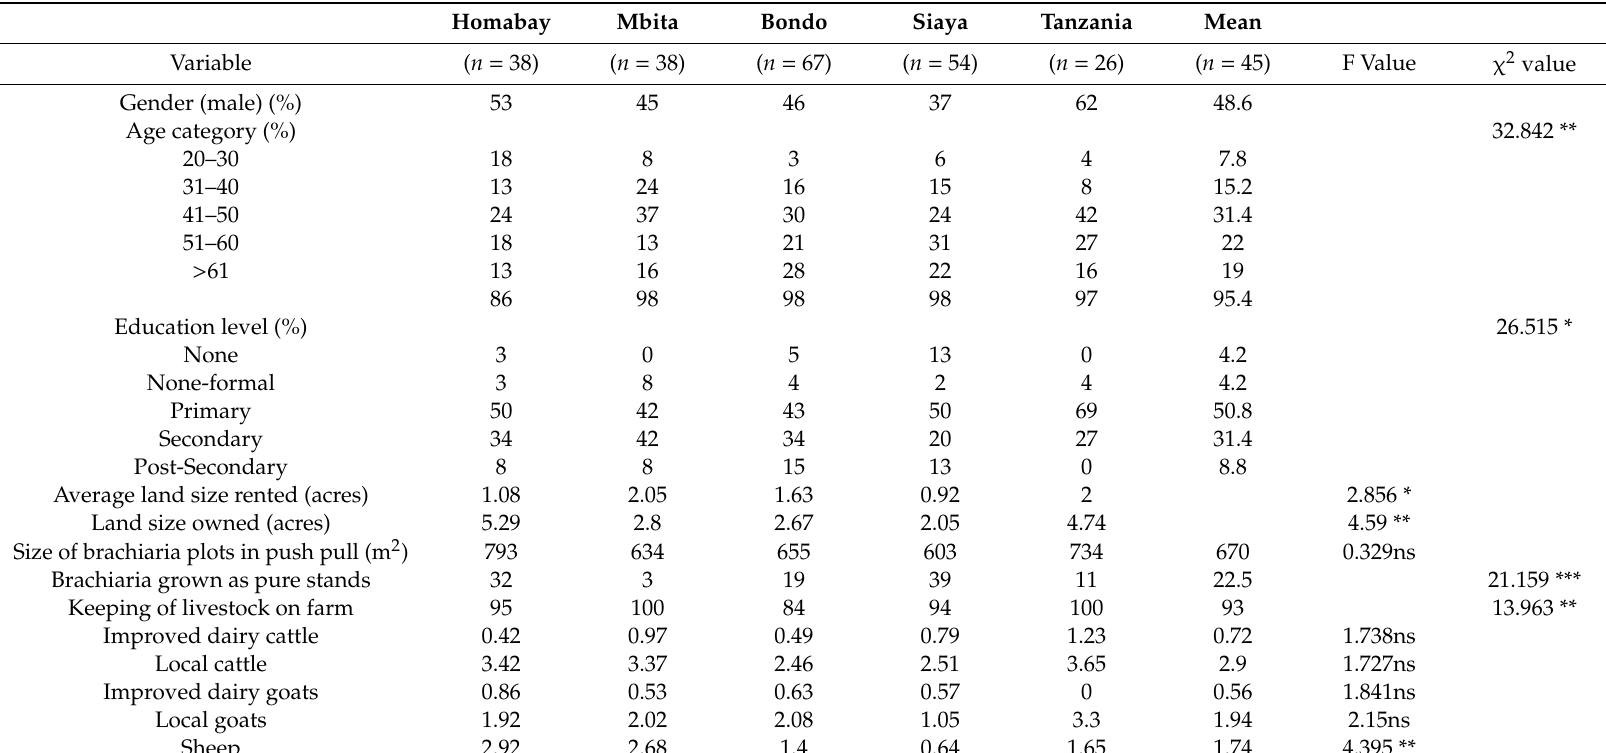
Table 1. Socio-economic characteristics of the